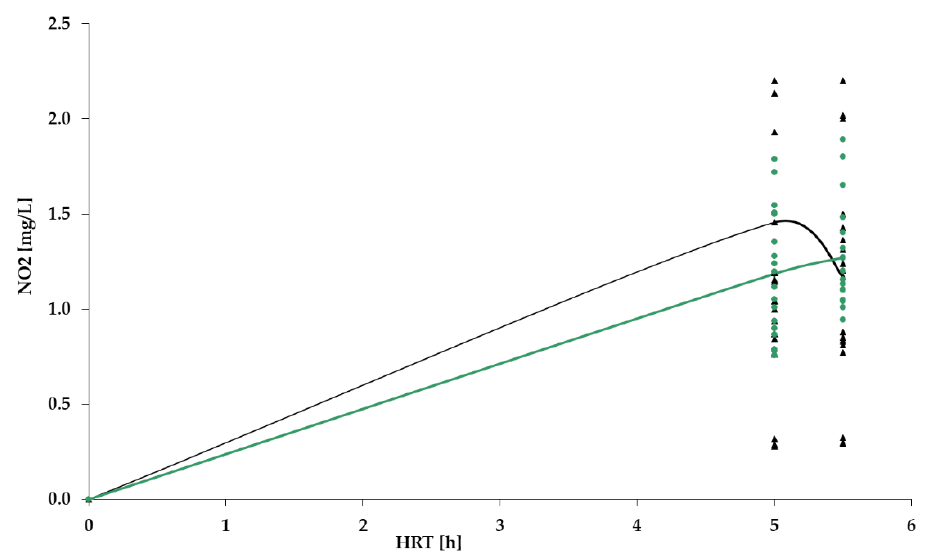
Figure 16. NO 2 dynamics for PV floating carrier: stage 1 (black); stage 2 (green).